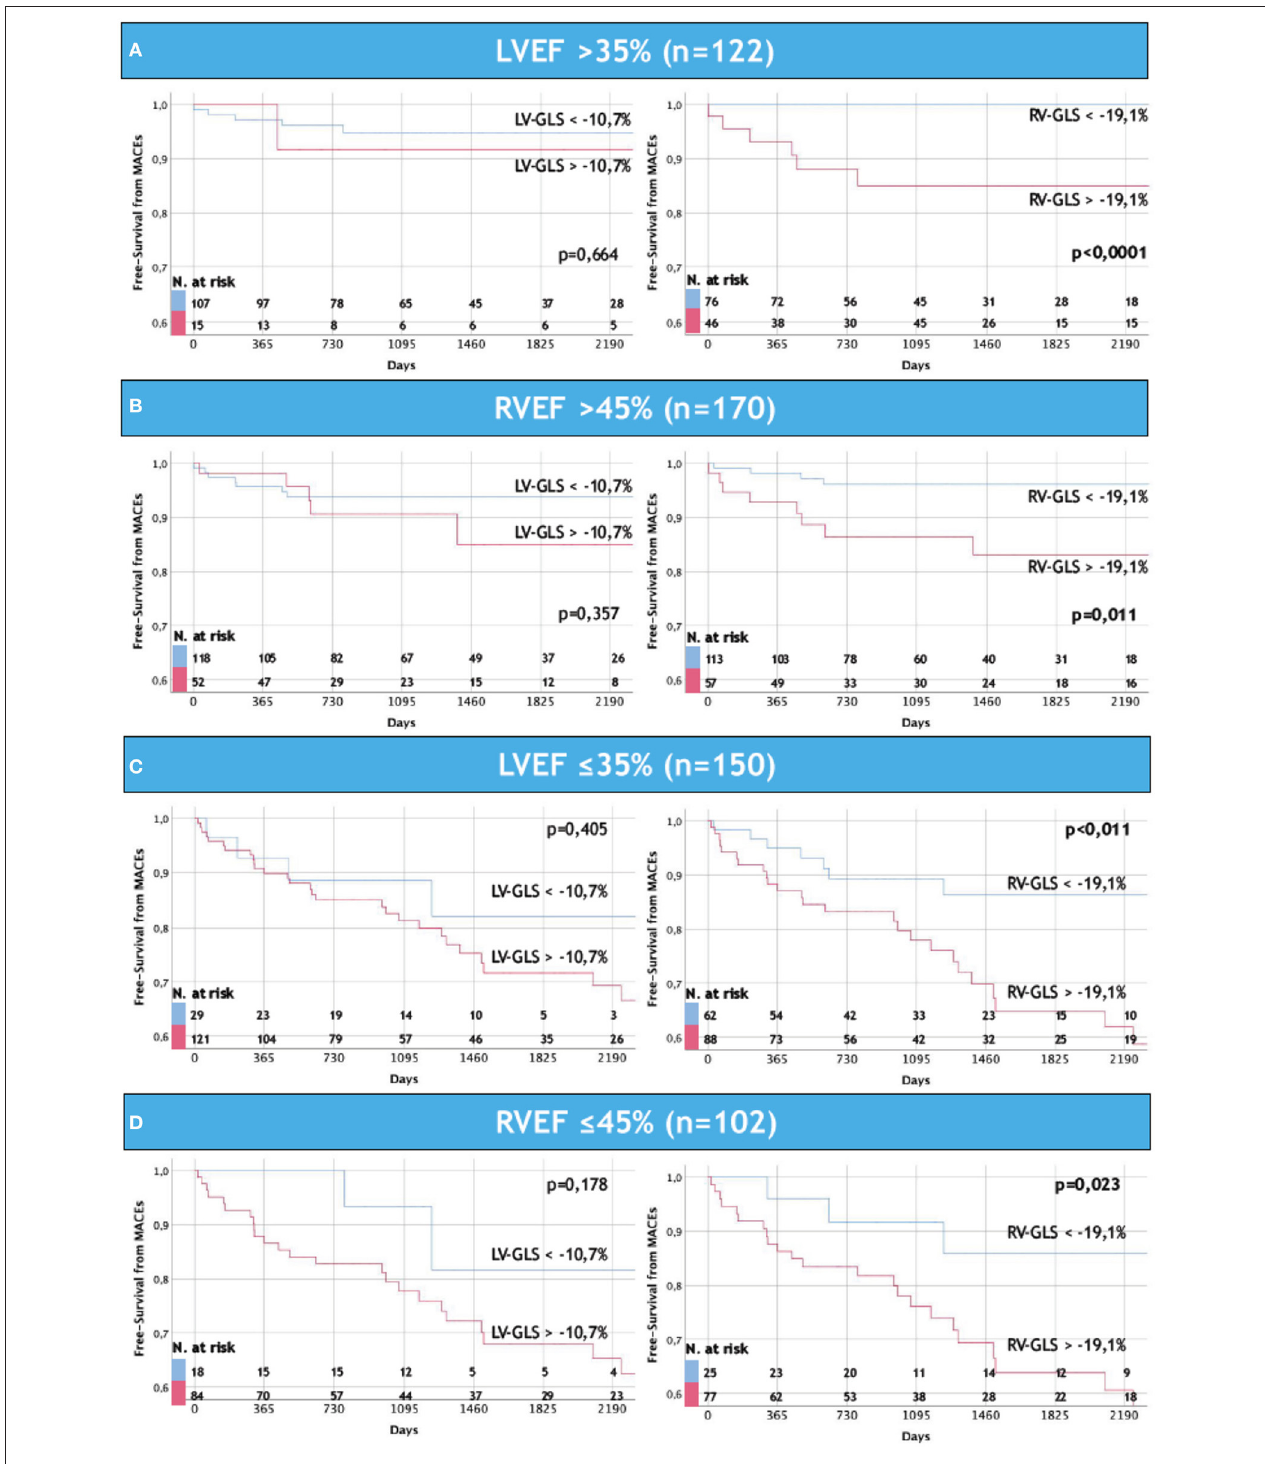
FIGURE 3 | Ability of RV-GLS to further stratify MACEs in NICM patients regardless severe LV and RV dysfunctions. Note how RV-GLS identifies MACEs independently to EF: in (A,B) are depicted patients with non-severe reduction of left (A) and right (B) ventricular ejection fraction, while in (C,D) are shown the remaining patients with severe reduction of left (C) and right (D) ventricular ejection fraction. The same power is not appreciated by LV-GLS in this recently onset NICM population. LVEF, left ventricular ejection fraction; LV-GLS, left ventricular global longitudinal strain; RVEF, right ventricular ejection fraction; RV-GLS, right ventricular global longitudinal strain; MACEs, major cardiovascular